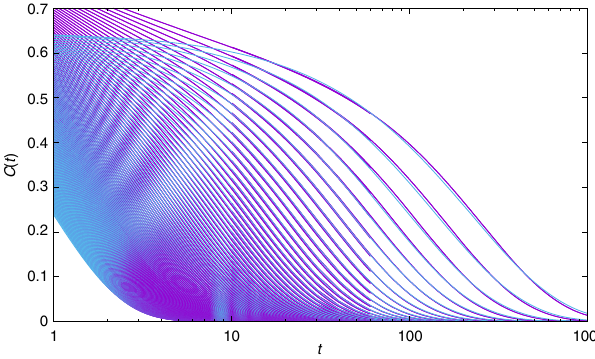
FIG. 21. Main panel: Equilibrium correlation function as a FIG. 22. Stretched exponential fit to the equilibrium correlation function of time on a log-linear scale at different temperatures function C ð t Þ for temperatures in the range T ∈ ½ 0 . 84 ; 2 (cid:2) in steps Δ T ¼ 0 . 01 . The fit has acceptable quality if the temperature is not from T ¼ 0 . 804 to T ¼ 0 . 813 in steps Δ T ¼ 0 . 001 (from top to bottom). All but the first two curves are for T > T too close to T . MCT ¼ MCT 0 . 805166 . We clearly see the formation of a plateau as T is MCT correspond, approached from above. The two curves below T MCT respectively, to q 1 ¼ 0 . 599574 and q 1 ¼ 0 . 614868 , which we show with dashed lines. Inset: Correlation C ð t Þ − q 1 at the critical temperature T on a log-log scale. For comparison, the dashed MCT line represents the expected behavior, a power law with exponent a ¼ − 0 . 38504 .